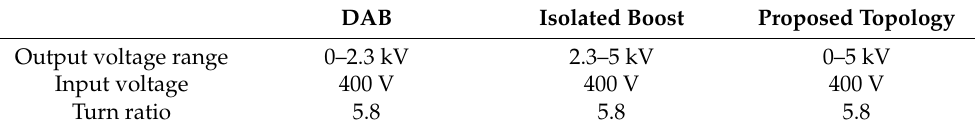
Table 4. Comparison of the output voltage range of different